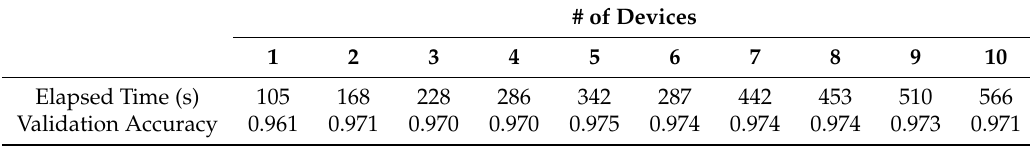
Table 1. Time and accuracy for training LeNet (multi-layer perceptron (MLP)).